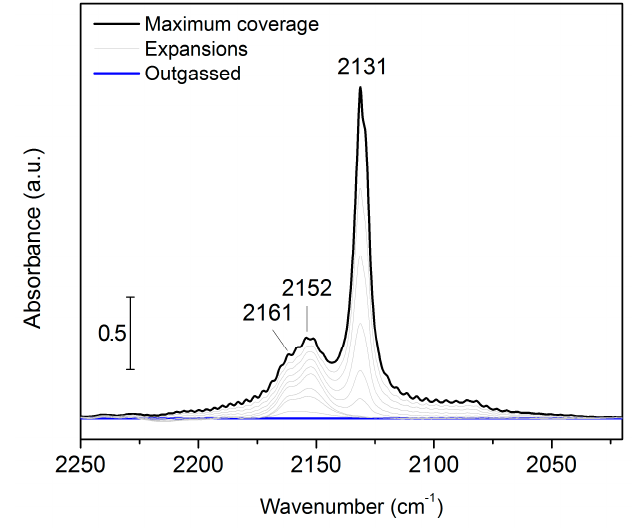
Figure 6. Background-subtracted CO adsorption FTIR spectra at − 196 °C on Ce 5 (BDC) 7.5 (DMF) 4 activated at 350 °C for 1 h.